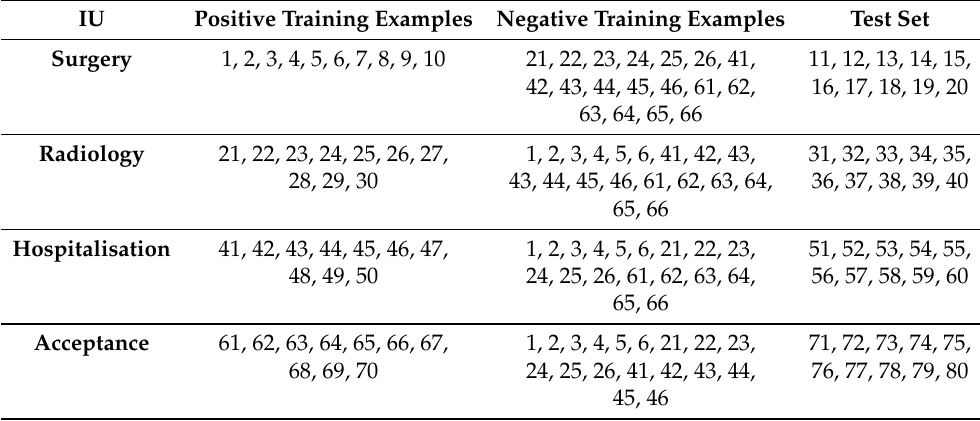
Table 1. Selection of the training set, along with its division into positive and negative examples, and the test set for the first version of the customised model. IU